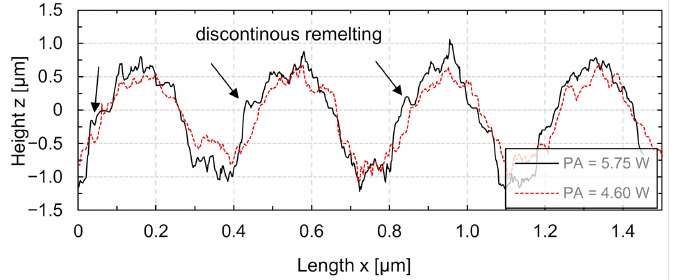
Figure 6. Longitudinal sections of single tracks after surface structuring using P A = 5.75 W and P A = 4.6 W ( d L = 50 µ m, v scan = 200 mm/s, λ = 0.2 mm, P M = 12.2 W). Continuous remelting no longer occurred at a laser power amplitude of P A =